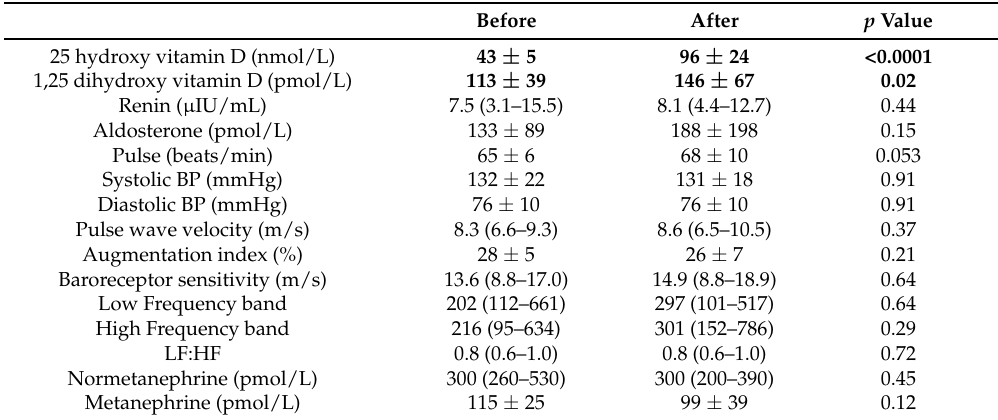
Table 3. Effect of the administration of 200,000 International Units vitamin D on the renin angiotensin system and cardiovascular function in 12